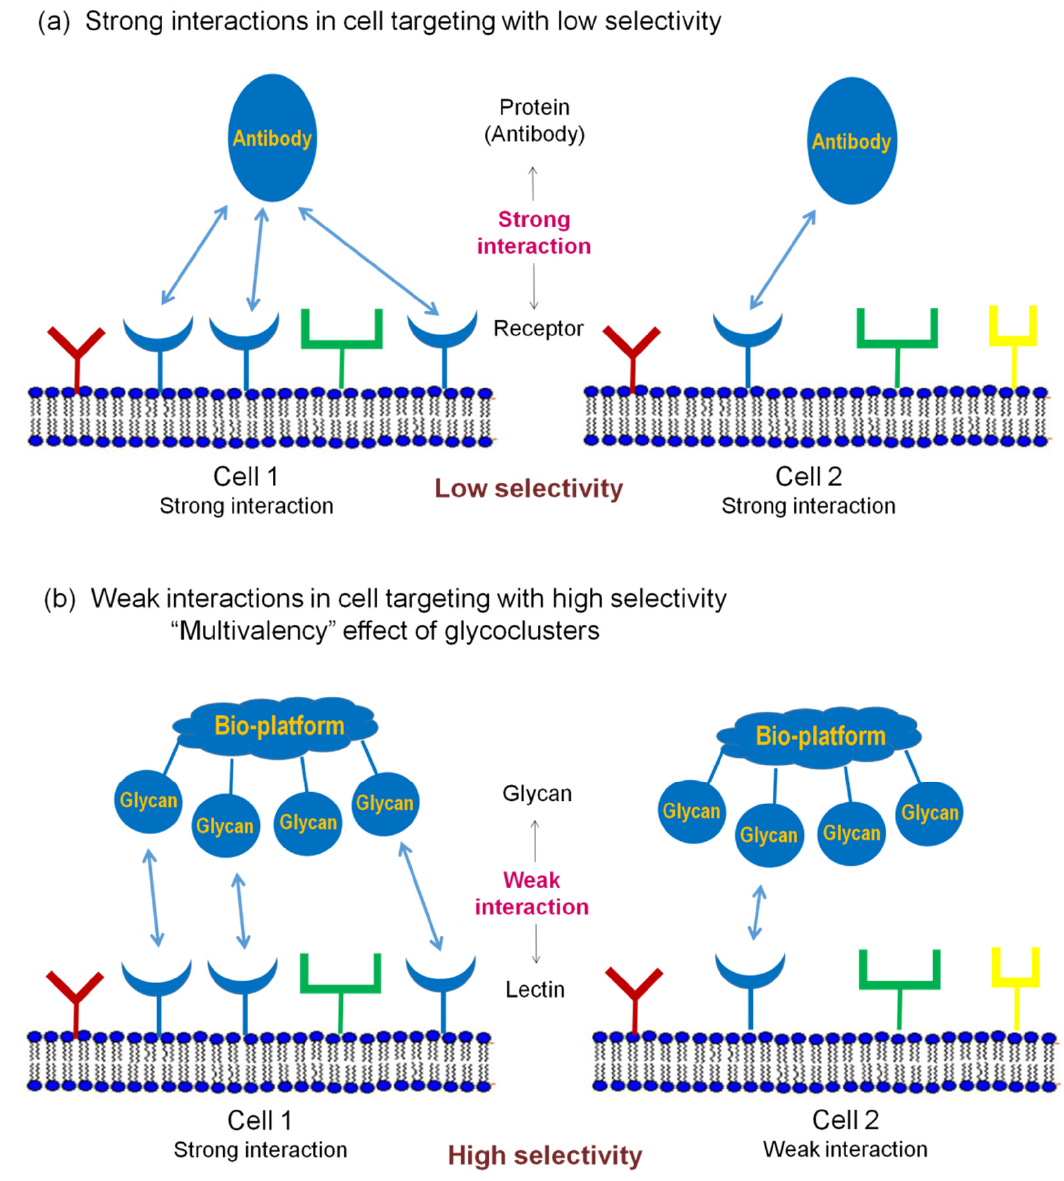
Figure 2. Cells targeting using ( a ) strong interactions, ( b ) weak interactions enhanced with multivalency effect of glycoconjugates. Receptors and glycans/antibodies of the same shape and color have interaction with each other. Bio-platform: cell, antibody, protein, etc. [44]. Copyright Wiley-VCH GmbH. Reproduced with permission.